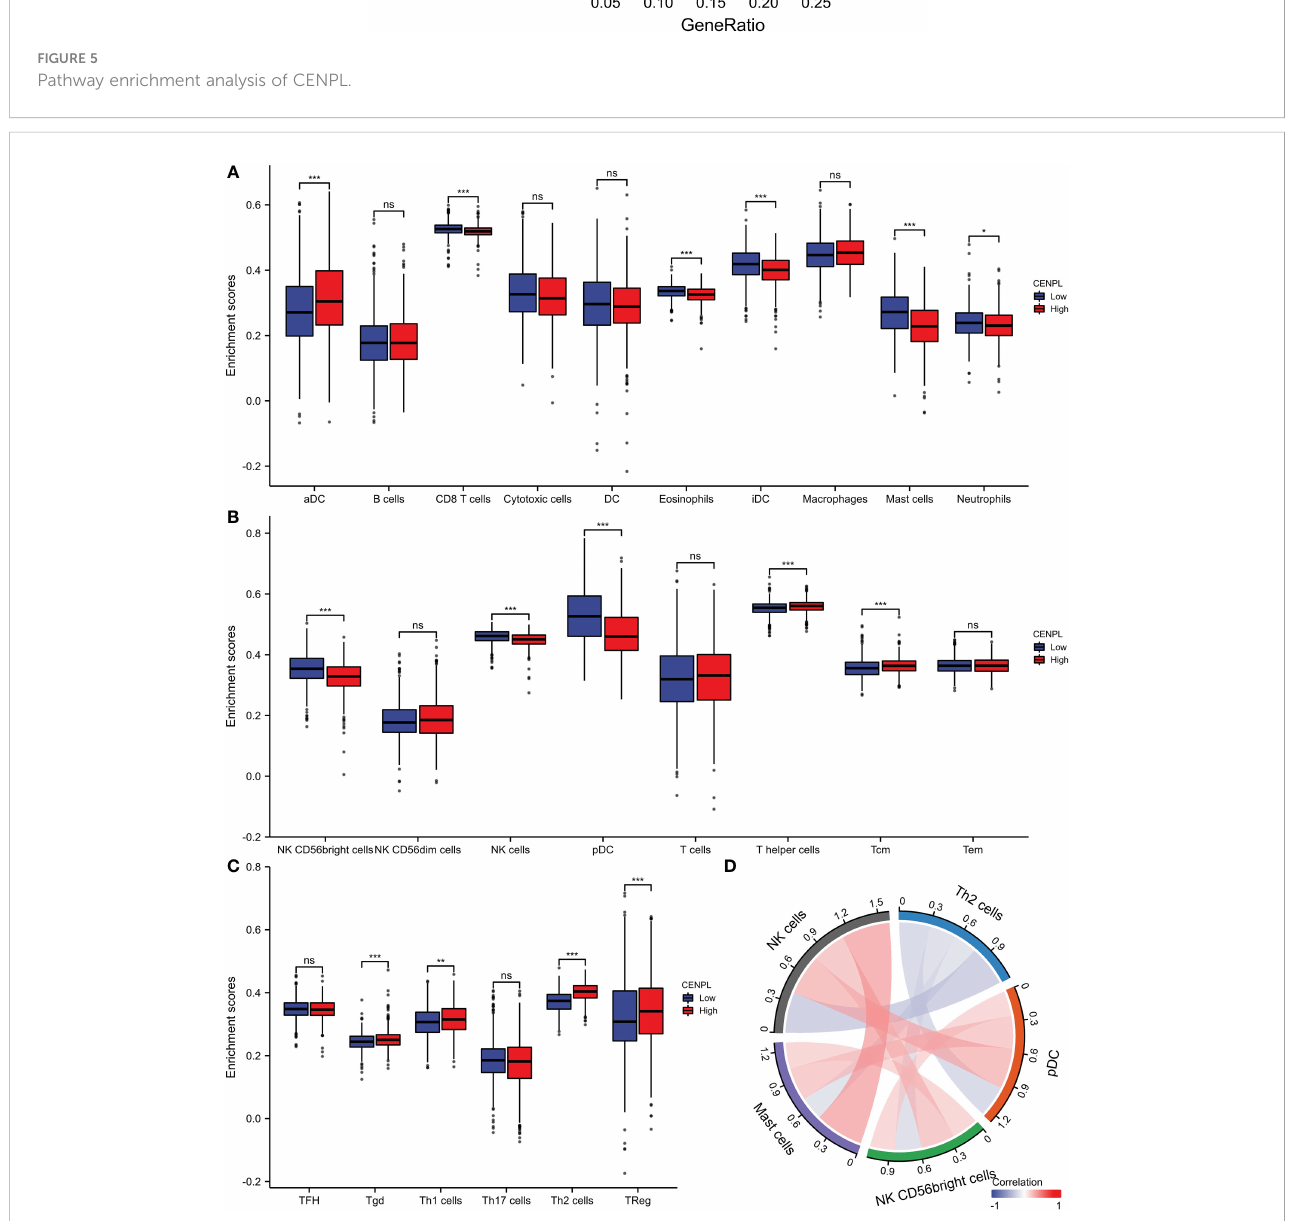
FIGURE 6 Analysis of CENPL and immune cell in fi ltration groups. (A-C) Grouping of immune cells based on CENPL expression levels. (D) Correlation of 5 immune